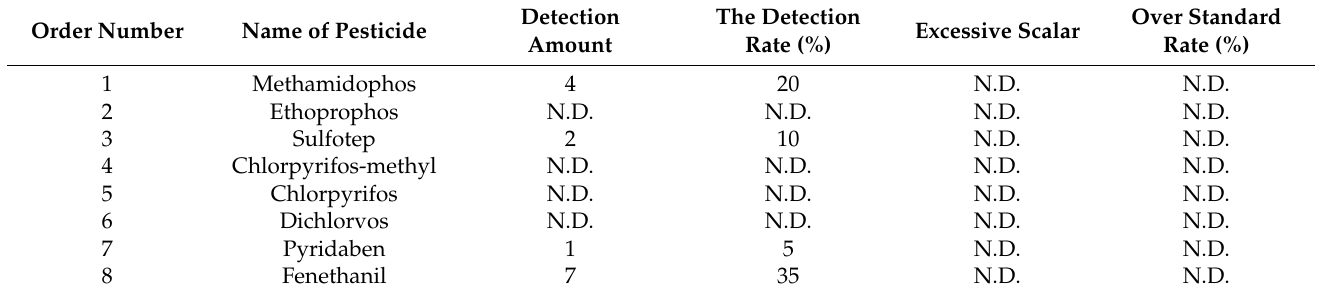
Table 2. Detection results of pesticides residue in